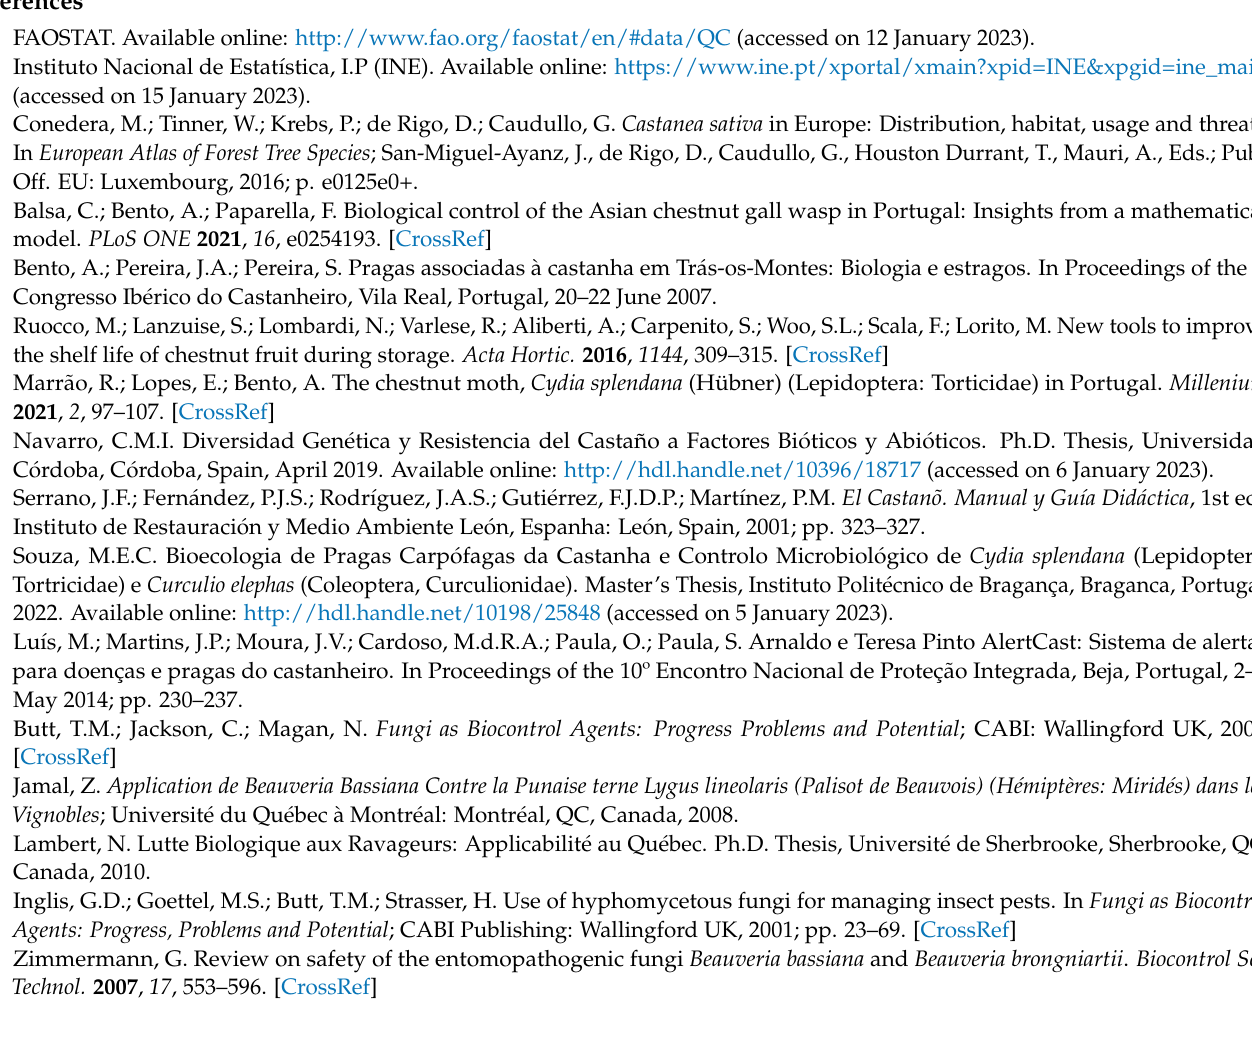
Figure A2. Monthly precipitation (mm) during the field trial period. * In June, only the first 15 days were considered, until the removal of the pots.